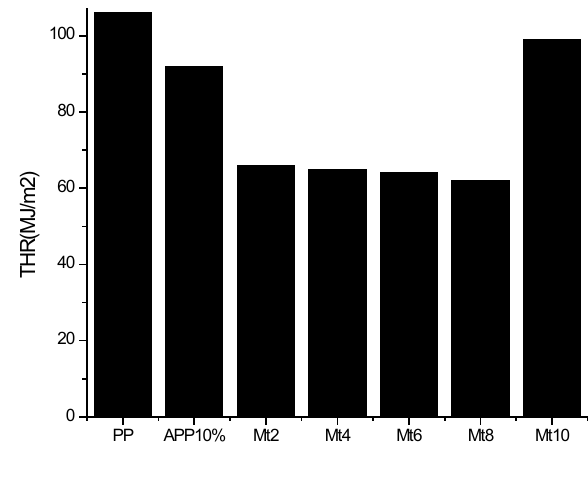
Figure 9: Total heat release of (PP, APP10% Mt2, Mt4, Mt6, Mt8, Mt10) samples.